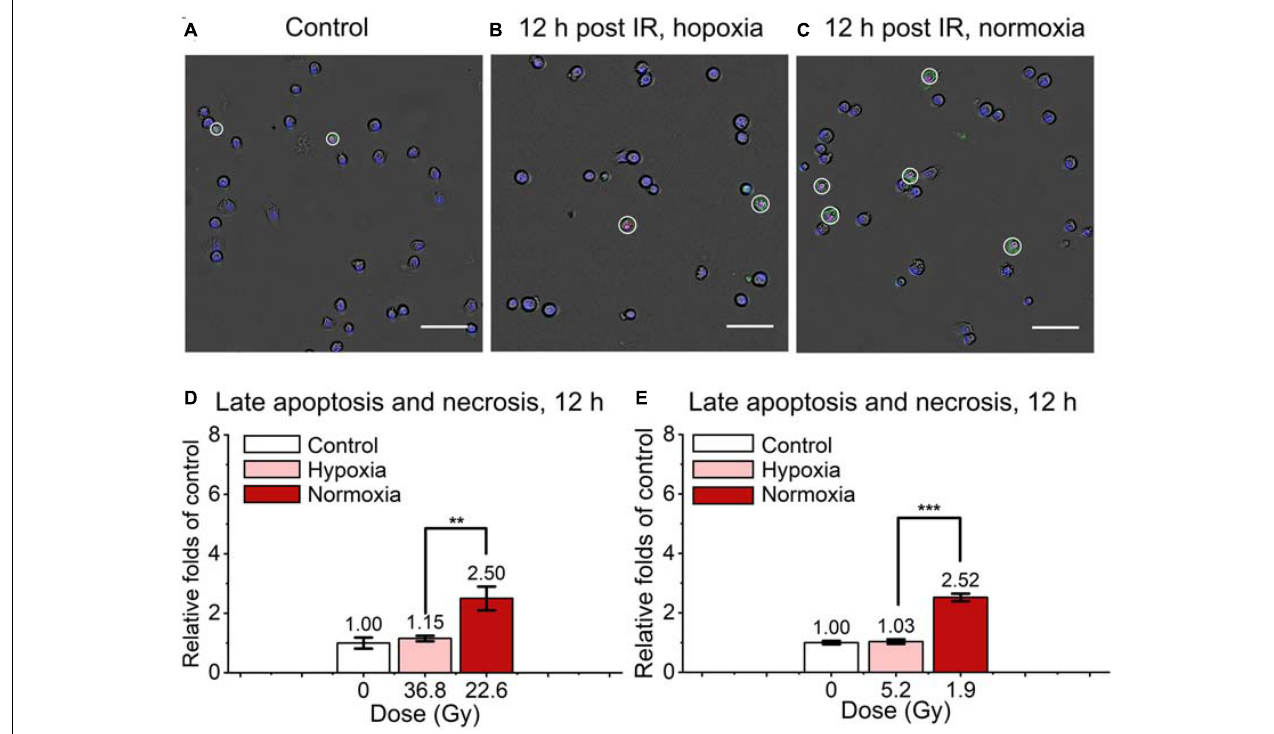
FIGURE 4 | Late apoptosis and necrosis of irradiated normal fibroblast cells after FLASH irradiation. (A–C) Representative images of control (A) , irradiated cells in hypoxic (B) and normoxic condition (C) at 12 h after radiation. Late apoptotic and necrotic cells were marked with white circles. Scale bars: 100 µ m. (D,E) The relative increasement of late apoptosis and necrosis in irradiated cells between hypoxia and normoxia at 12 h after high (D) or low (E) doses of